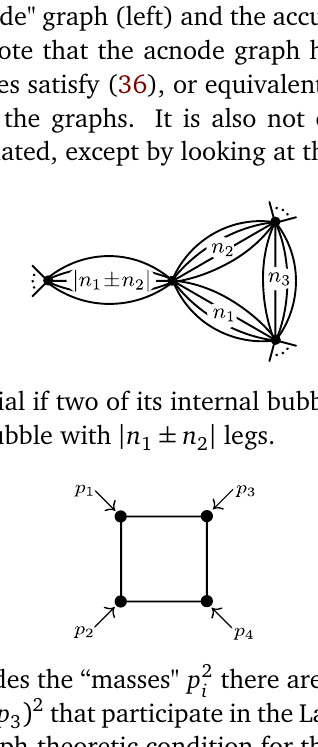
Figure 18: Box graph. Besides the “masses" p 2 there are also Mandelstam invariants i + p ) 2 and t = ( p + p ) 2 that participate in the Landau equations. This makes s = ( p 1 2 1 3 it hard to find a generic graph-theoretic condition for the box graph to be